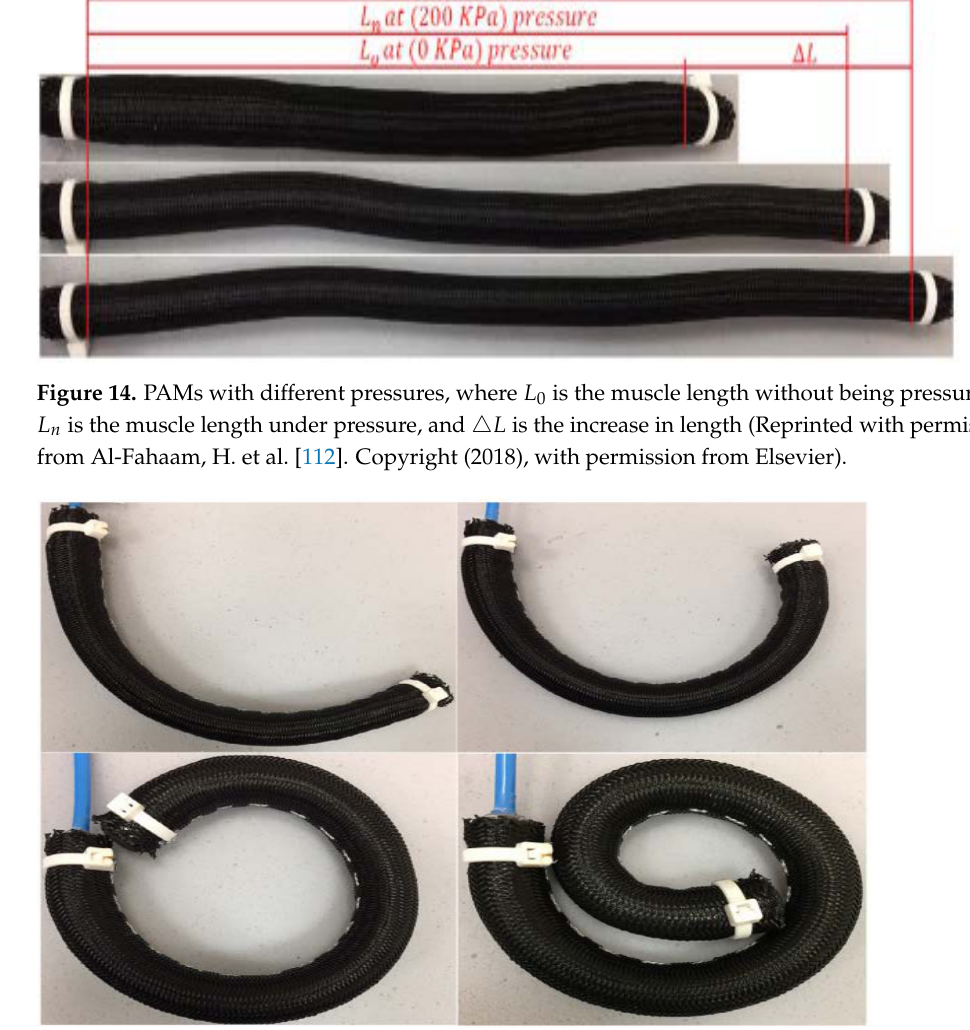
Figure 15. EBPAM pressurized under different amounts of pressure; increasing from top-left to bottom-right (Reprinted with permission from Al-Fahaam, H., et al. [112]. Copyright (2018), with permission from Elsevier).